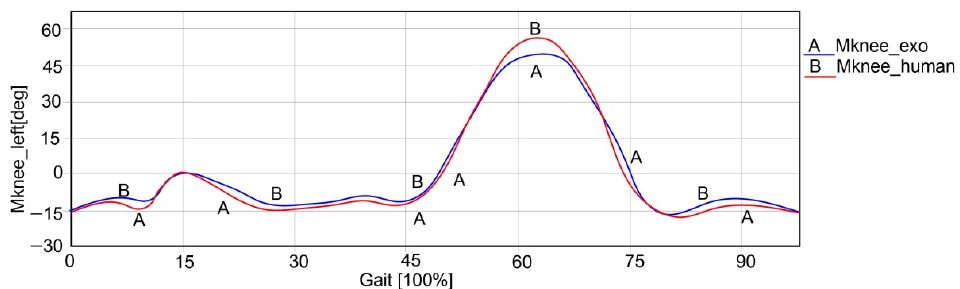
Figure 32. Right knee angular variation exoskeleton vs. human subject during a complete gait.